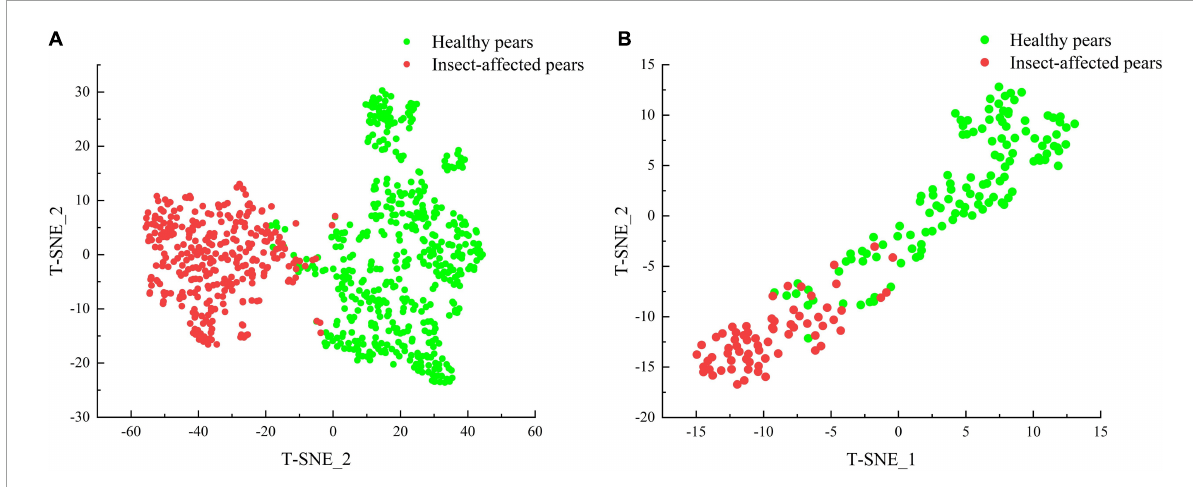
FIGURE11 Visualization of output features by T-SNE: (A) Calibration set features distribution, (B) validation set features distribution.